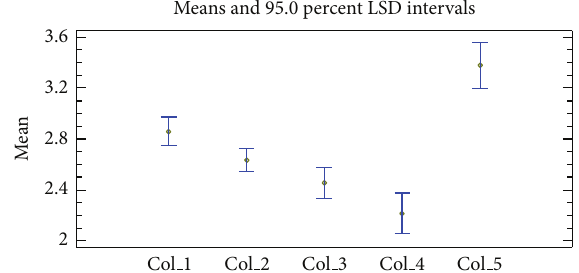
Figure9:Evaluationofsensoryanalysesofdriedfishsamples.Col 1: Channa, Col 2: Nile tilapia, Col 3: walking catfish, Col 4: climbing perch, and Col 5: swamp